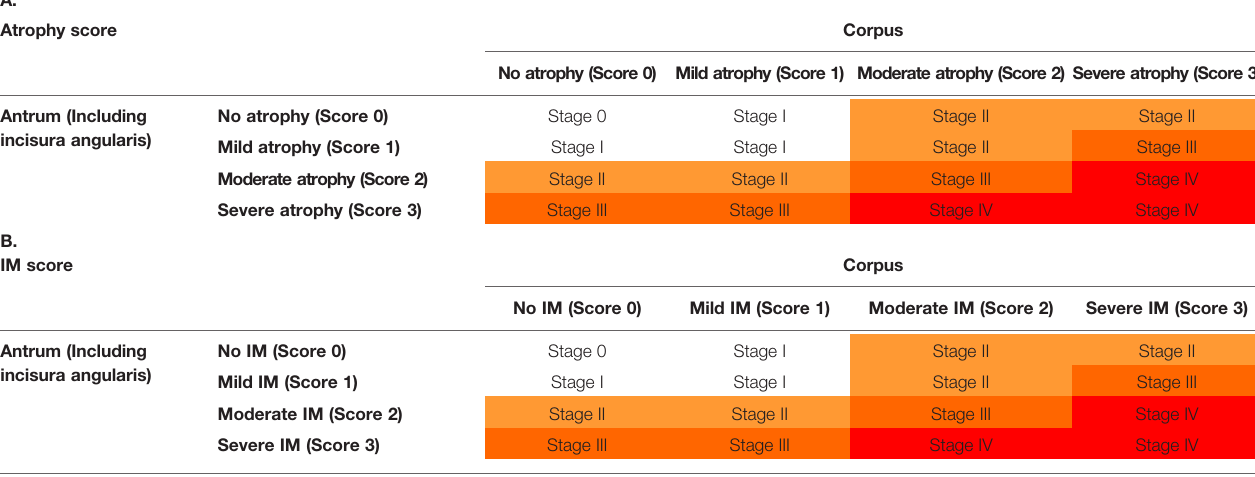
Operativelinkongastritisassessmentstagingsystem (A) andoperative linkongastricintestinalmetaplasiaassessment (B) stagingsystem. IM,intestinal metaplasia;OLGA,Operativelink on gastritis assessment system; OLGIM, Operative link on gastric intestinal metaplasia assessment. Adapted from Weng CY et al. (27) Higher intensity of colour means higher risk of Early Gastric